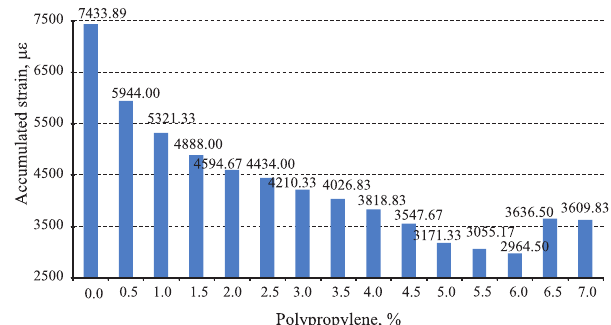
Fig. 2. Accumulated strain values for 15 sets of specimens at the end of static creep tests